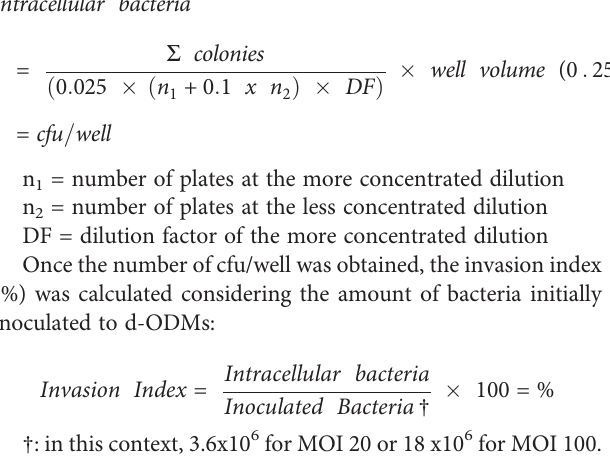
TABLE 1 | Adjustment of the added bacterial-culture volume to the d-ODM culture depending on the tested MOI. MOI 20 MOI 100 Number of d-ODM-cells: 180,000 Number of d-ODM-cells: 180,000 Final cfu/ml (fC):